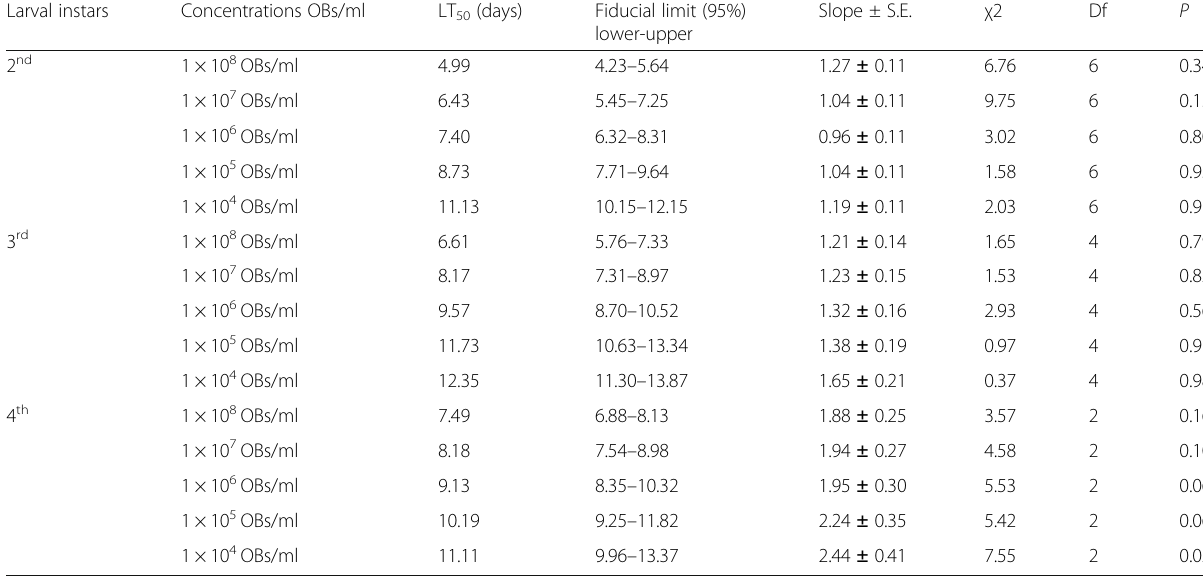
Table 2 LT 50 values of Spodoptera litura larvae exposed to various concentrations of V- Splt NPV Larval instars Concentrations OBs/ml